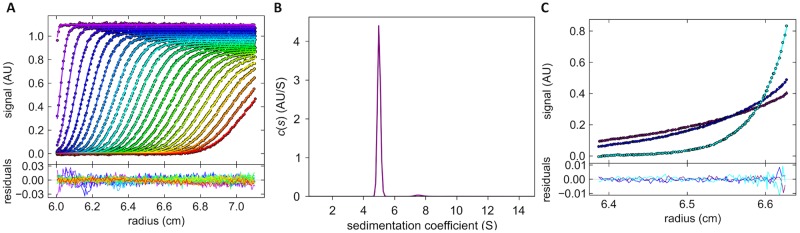
(A, B). Sedimentation velocity experiment. Sedimentation profiles and fitted curves of PHL (0.12 mg/ml) in 100 mM NaCl, 20 mM Tris/HCl, pH 7.5 obtained from continuous c(s) analysis using Sedfit (A, upper panel). The experiment was carried out at 42,000 rpm at 20°C, and the scans were recorded every 6 minutes. For simplicity, every third scan is shown. Residual plot (A, lower panel) shows the differences between experimental data and fitted curves, thus reflecting the quality of the fit. The continuous size distribution of sedimenting species (B) for PHL resulted in a peak with a sedimentation coefficient of 4.98 S (s20, w = 5.12 after extrapolation to standard conditions in Sednterp). The value is clearly much higher than the predicted maximum value for a spherical monomer (4.33 S as calculated in Sednterp), suggesting that a dimer with a moderately elongated shape (frictional ratio of 1.34) is formed. The figures were created in the program GUSSI 1.0.8 [24]. (C) Sedimentation equilibrium experiment. Equilibrium distributions of PHL (0.05 mg/ml) were obtained at 20°C at rotor speeds of 9,500 (purple curve), 11,400 (dark blue) and 20,000 rpm (light blue). The residual plot (lower panel) shows the goodness of the fit. A global analysis of multi-speed experiments (for all loading concentrations of PHL) using SEDPHAT gave a molecular weight of 78.6 kDa. This value corresponds well with the theoretical molecular weight of the dimer (80.1 kDa). The figure was created in GUSSI 1.0.8.